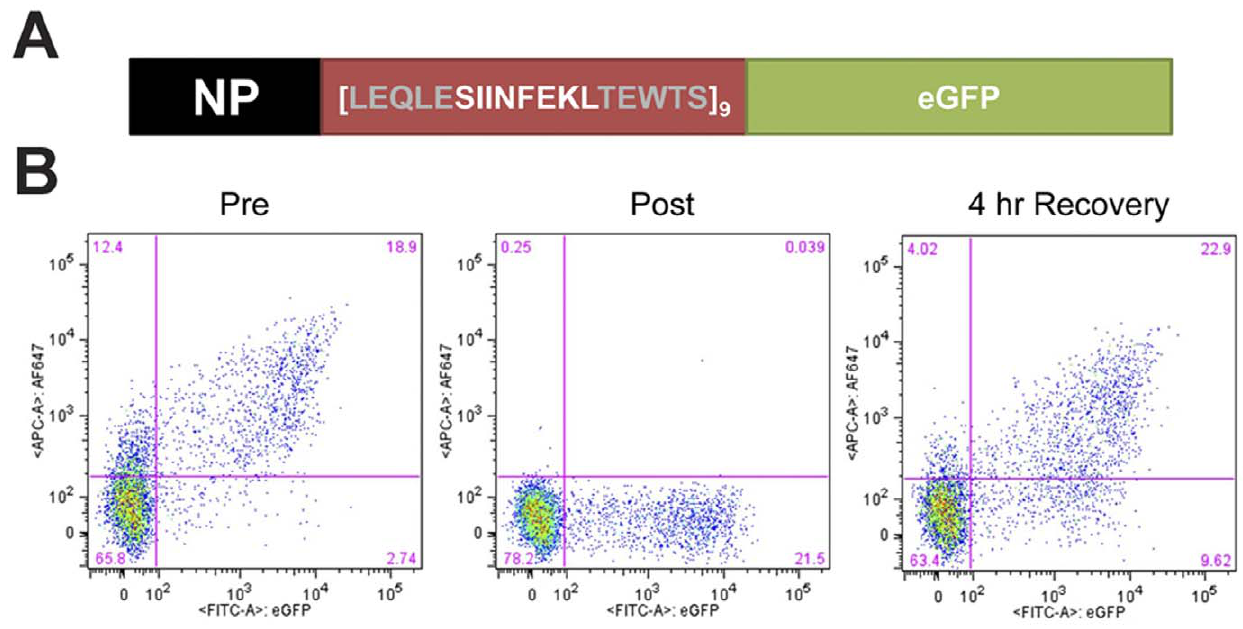
Figure 5. MHC class I-peptide complex recovery assay using a fluorescent reporter encoding antigenic peptides. A. Schematic of the modified NP-SIINFEKL-eGFP reporter (adapted from [2]) containing eight additional tandem repeats of SIINFEKL (nine total) and its five flanking amino acids from the native ovalbumin sequence, NP-[SIINFEKL] 9 -eGFP (Tandem Repeat x9 or TRx9). B. Validation of MHC I peptide stripping and recovery in TRx9-expressing cells. Biexponential scatter plots show single cell profiles of the mean fluorescence intensity (MFI) for eGFP on the x -axis and 25- D1.16 on the y -axis. Plots show fluorescence profiles immediately pre- ( left ) and post- ( middle ) peptide stripping, and after a 4 hour recovery ( right ).